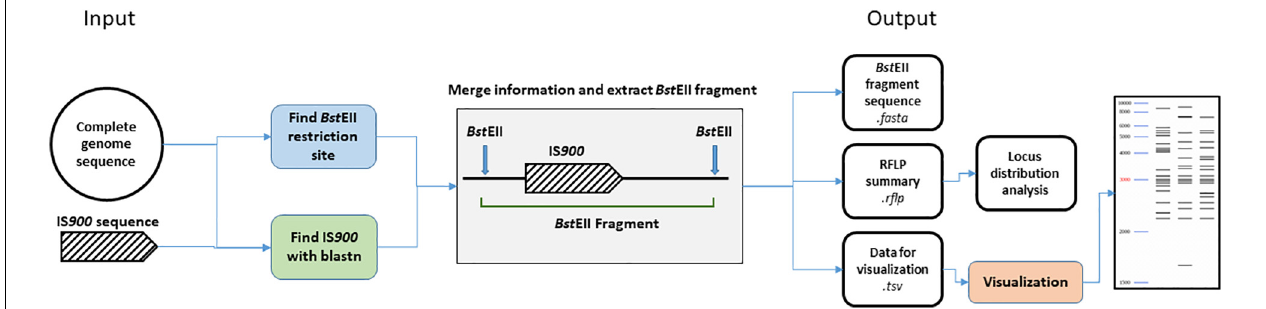
FIGURE 1 | Bioinformatic analysis pipeline. Details of steps performed by the IS 900 RFLP in silico pipeline. From complete genome sequences, Bst EII restriction site and IS 900 sequence positions were identified. Both data sets are merged together to extract the Bst EII fragment sizes from the genome sequence. Previous positions IS 900 and sequence orientation are stored in a.rflp file for further analysis. Bst EII fragment sizes are converted into migration distance based on calculation from an in vitro gel migration (see section “Materials and Methods”) and saved in the .tsv file for further visualization of the RFLP